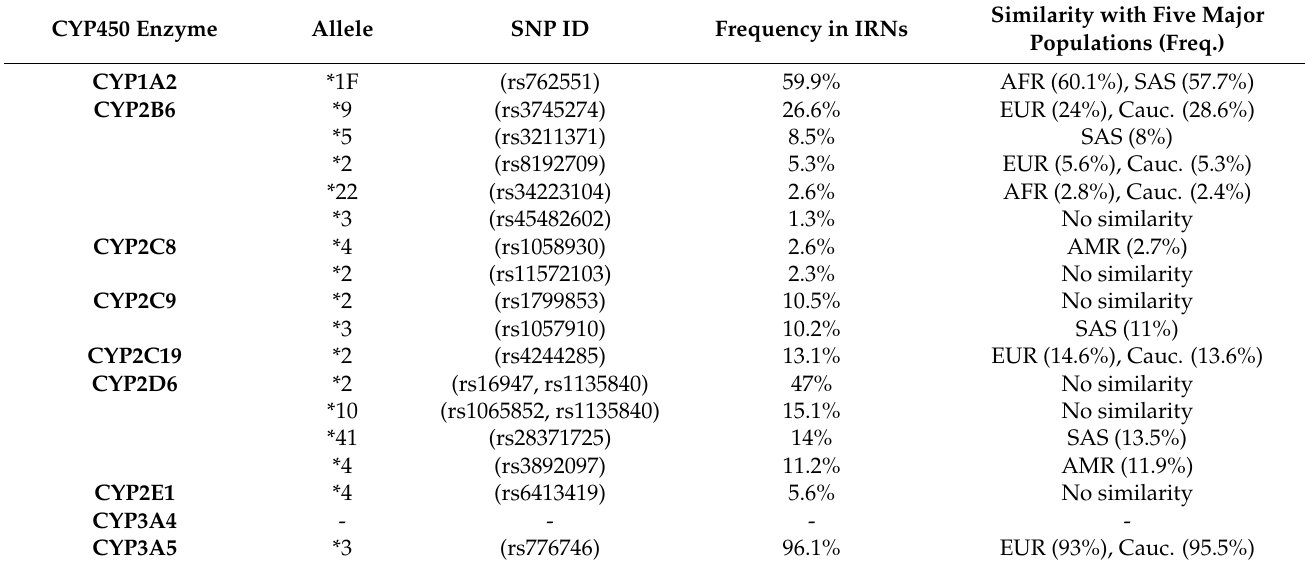
Table 2. Similarity of high-frequency CYP alleles in the Iranian population with other populations. CYP450 Enzyme